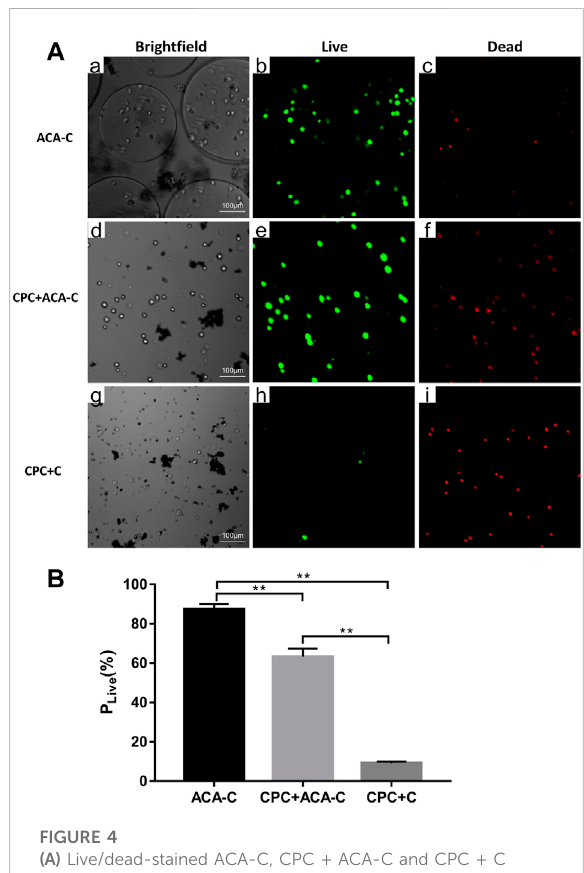
FIGURE 4 (A) Live/dead-stained ACA-C, CPC + ACA-C and CPC + C cells observed via laser scanning confocal microscopy. The live cells were green, and the dead cells were red, bar = 100 μ m.